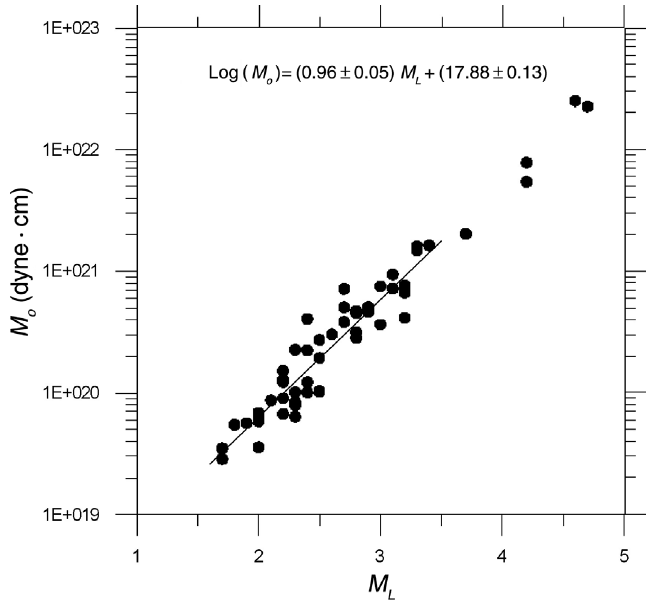
Fig. 4. Plot of seismic moment versus local